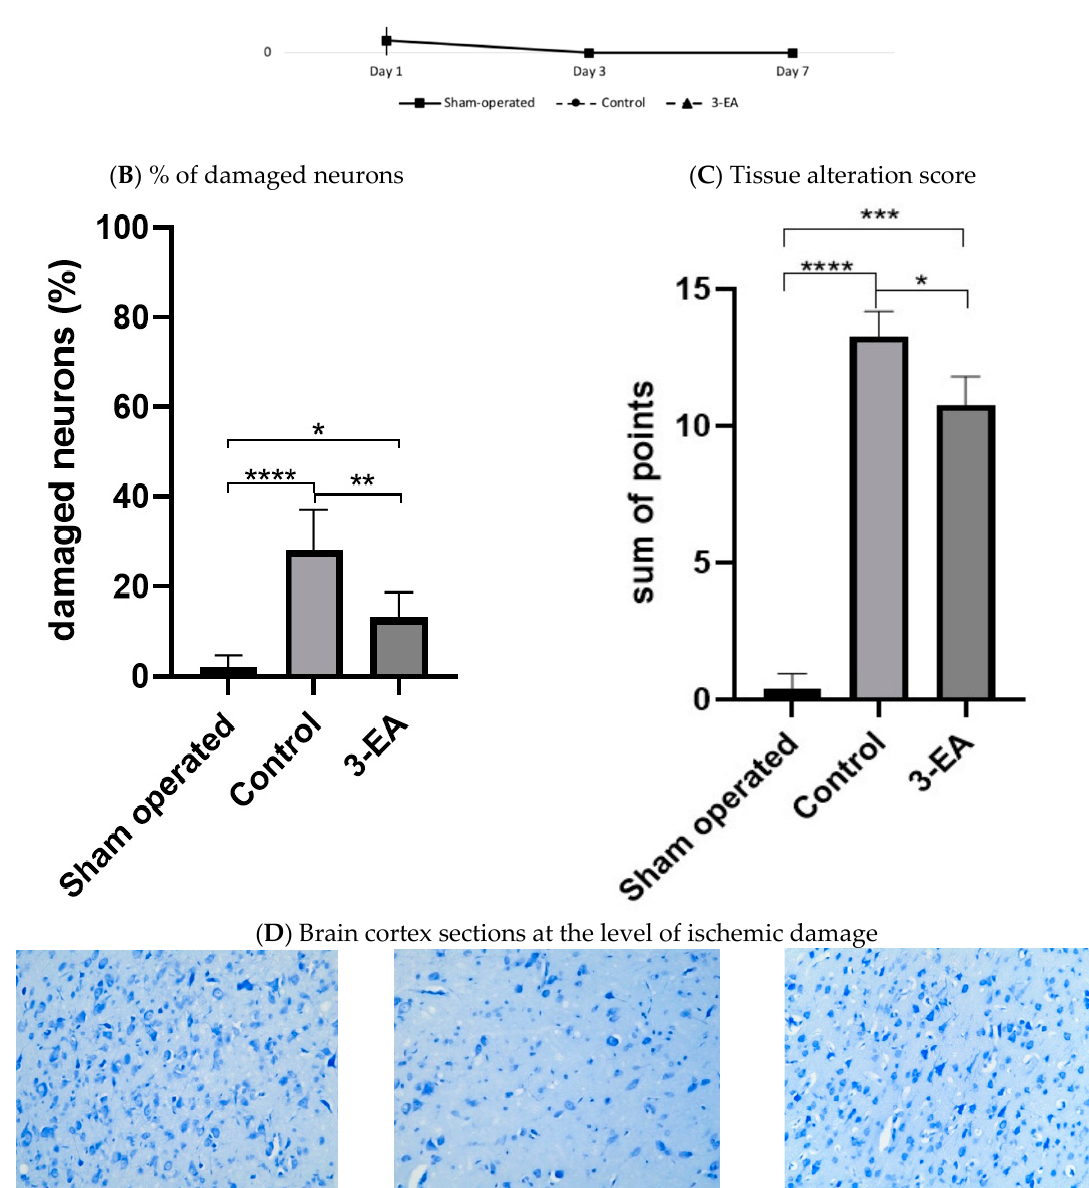
Figure 7. Neurological disorder and brain tissue damage in experimental groups 7 days after MCA occlusion; staining by the Nissle method, ×200; n = 6 in each group, data presented as mean ± SD, f p < 0.05 when compared to sham-operated group, a p < 0.05 when compared to control group; * p < 0.05, ** p < 0.01, *** p < 0.005, **** p < 0.001 in intergroup comparison; significance of differences was assessed by ANOVA and the Tukey’s test.